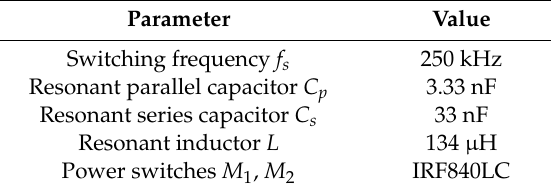
Table 2. Resonant Inverter parameters.